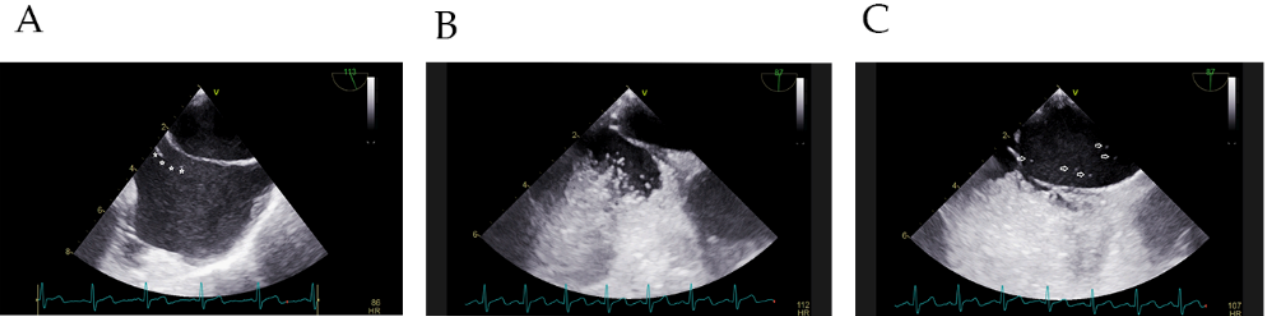
Figure 4. The cTEE images in a 34-year-old man with PFO. ( A ) shows the EV in the right atrium. The white asterisks indicate the outline of EV. ( B ) Due to the obstruction of the prominent EV during diastolic phase, microbubbles could not enter the left atrium through PFO. ( C ) The prominent EV rolled during the systolic phase; microbubbles could enter the left atrium through PFO. The white arrows indicate the microbubbles in the left atrium. cTEE = contrast transesophageal echocardiography; EV = Eustachian valve; PFO = patent foramen ovale (Videos S1 and S2).